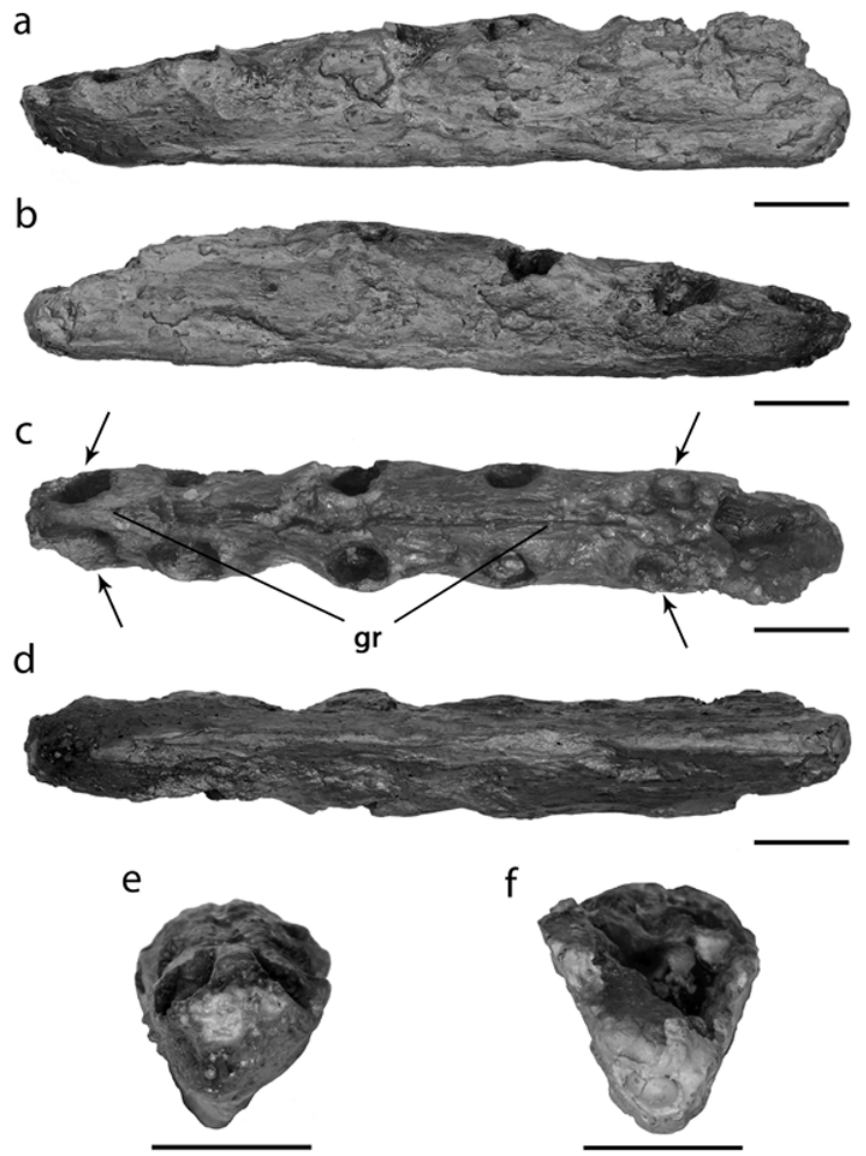
Fig. 2 – Aussiedraco molnari gen. et sp. nov. from the Toolebuc Formation, western Queensland, Australia. Cast (MN 4721-V) of the holotype (QM F10613). Mandibular symphysis: a, left lateral; b, right lateral; c, dorsal; d, ventral; e, anterior and f, posterior views. Setae indicate the first and last alveoli on each side. Abbreviation: gr – groove. Scale bar: 10